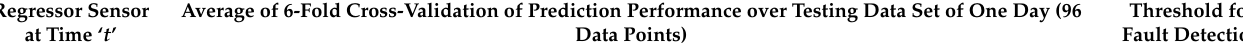
Table 11. Prediction performance of Recurrent Neural Network for selected regressors